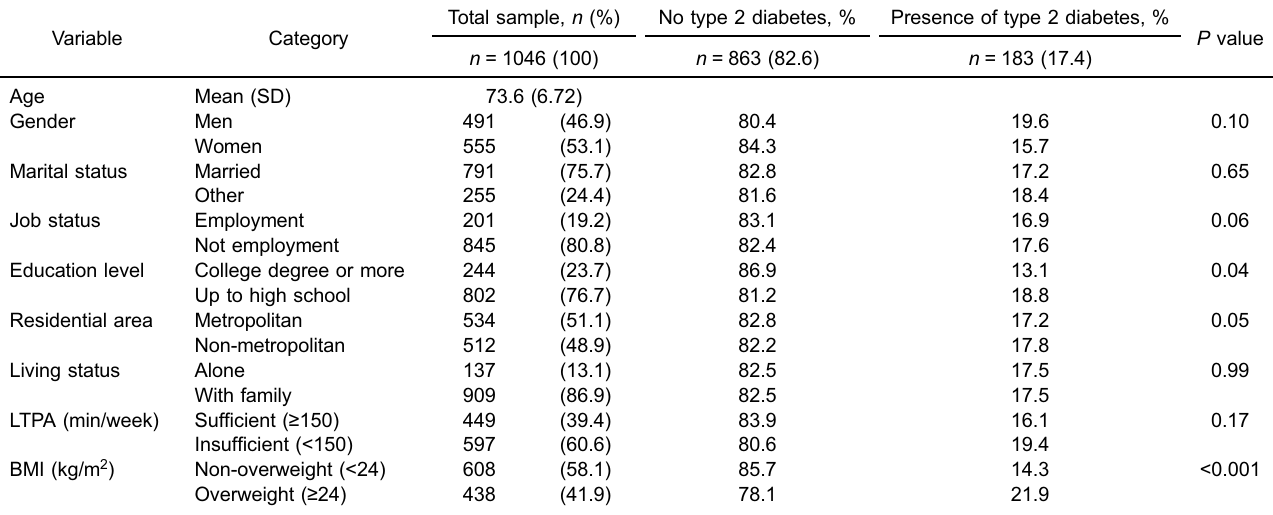
Table 1. Characteristics of participants